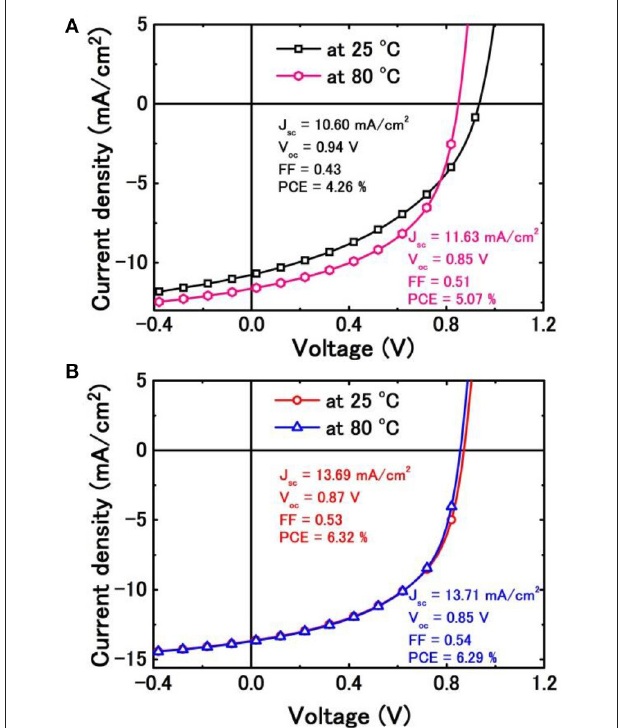
FIGURE 7 | (A) J - V characteristics of the solution-processed DIBSQ:PC 71 BM SMBHJ cells at 25 and 80 ◦ C; and (B) J - V characteristics of the vacuum-processed DIBSQ:C 70 SMBHJ cells at 25 and 80 ◦ C.